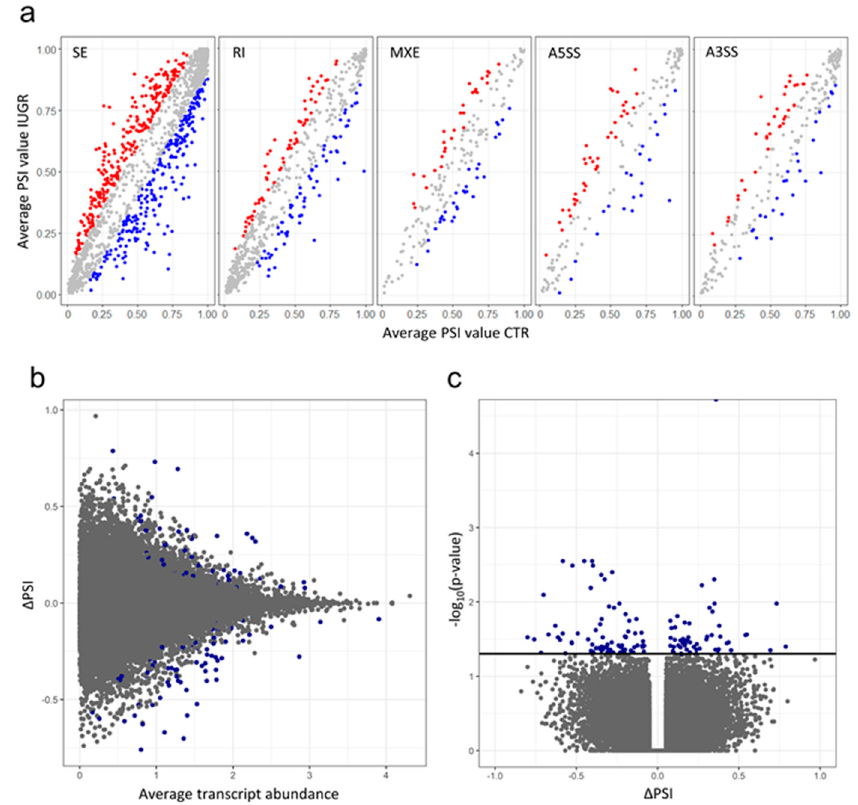
Figure 4. The abundance of alternative splicing events. ( A ) Dot plots for five alternative splicing (AS) events types depicting imbalance in percent splicing inclusion (PSI) values investigated by rMATs. Red and blue dots indicate significant AS events with higher PSI value in IUGR-affected and control libraries, respectively. Grey dots represent no changes in PSI ratio. ( B ) MA plot showing changes in the percentage of transcripts with the exon spliced in ( ∆ PSI) plotted against average transcript abundance for all AS events detected in IUGR-affected and control libraries retrieved by SUPPA. ( C ) ∆ PSI values of each AS event were presented on X-axis and the negative logarithmic adjusted p -value was presented on the Y-axis. Horizontal line indicates negative logarithmic adjusted p -value (0.05) cut-off. Each point (dot) on Volcano and MA plot represents the splicing event; blue dots represent significant DAS events (adjusted p -value < 0.05) and grey dots were not significant.